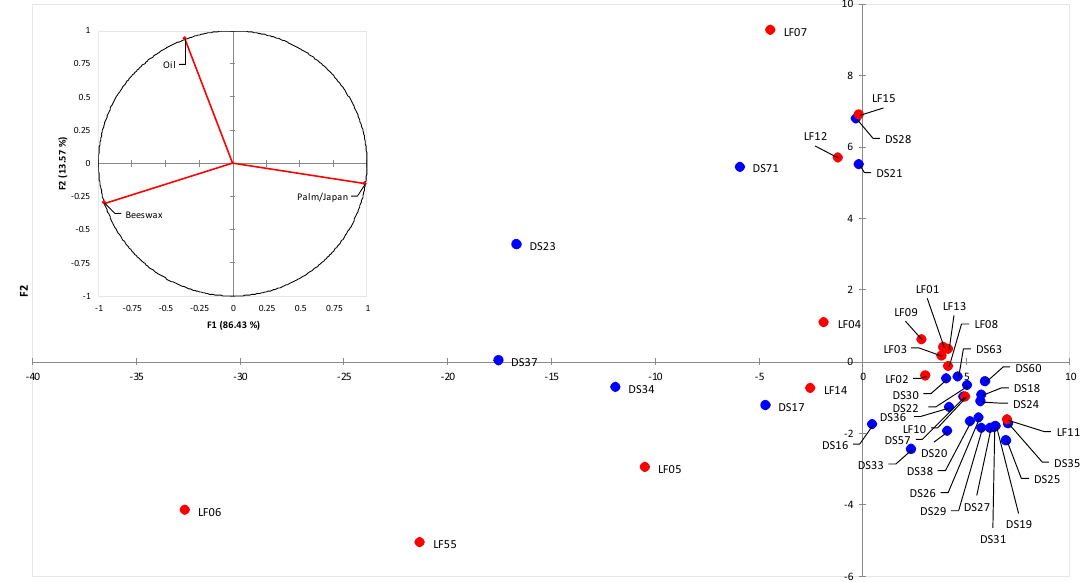
Figure 7. PCA score and loading plots obtained by processing the FIA-ESI-Q-ToF raw data (DS032 not included). Red: LeFranc; blue: Dr. F.